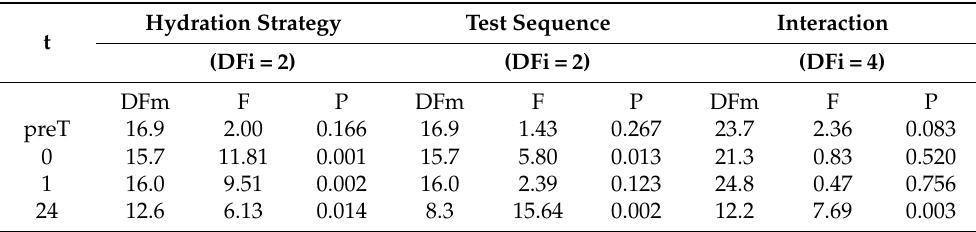
Table 12. Results of analysis of variance for WBC measured before the test (preT) and 0, 1, and 24 h after the exercise test: significance of (P) and F-statistic along with the number of degrees of freedom (DFi—in the numerator; DFm—in the denominator) for the fixed effects (hydration strategy, test sequence, and their interaction).